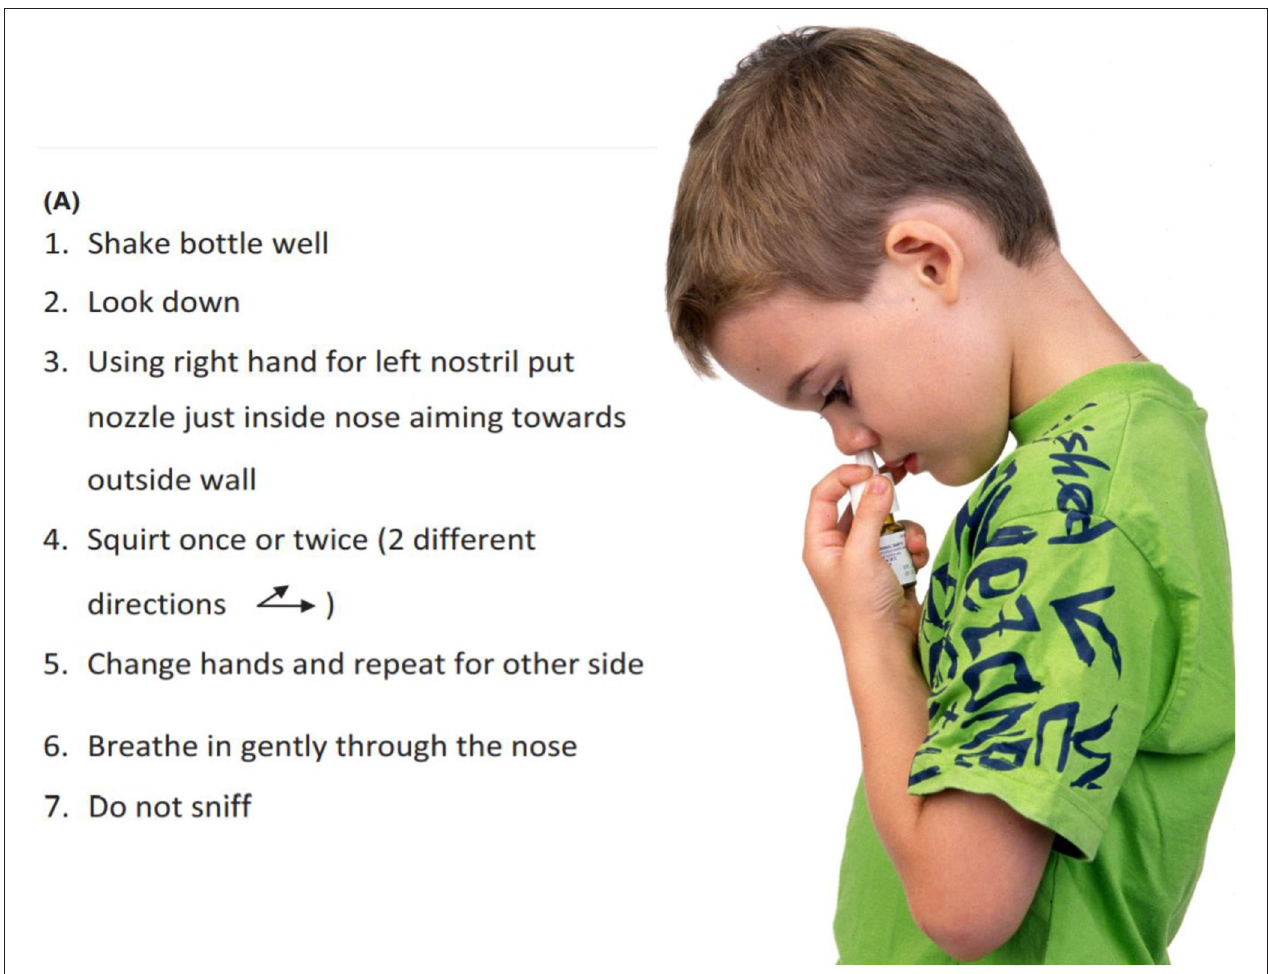
FIGURE 6 | How to use a nasal spray. It is necessary to put the spray onto the lateral walls of the nose, not the septum. It should not be sniffed back hard into the nose but should be moved slowly by mucociliary clearance over the nasal mucosa where the corticosteroid can enter epithelial cells to exert its effects. From Scadding et al. ( 12), with